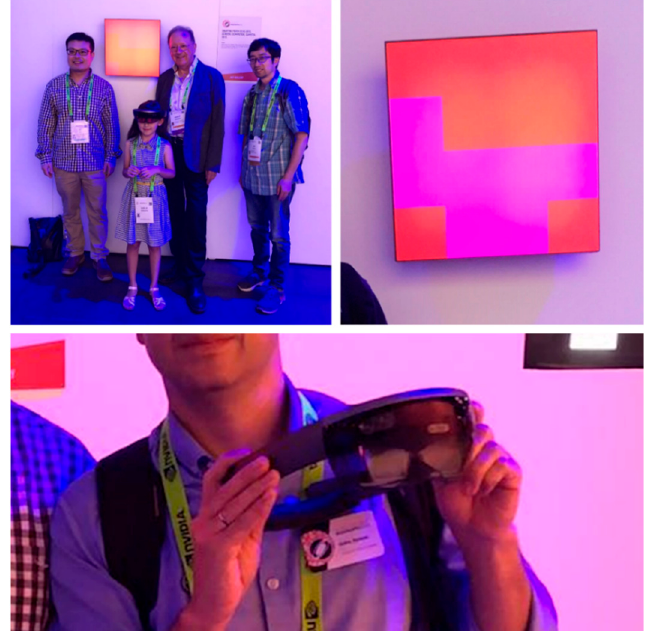
Figure 6. “H Space” (2018) by Ernest Edmonds in collaboration with Yingqing Xu, Xin Tong, YI JI and Damian Hills. Used by permission of Milton Sogabe. Photographs by Milton Sogabe and Andres Burbano.